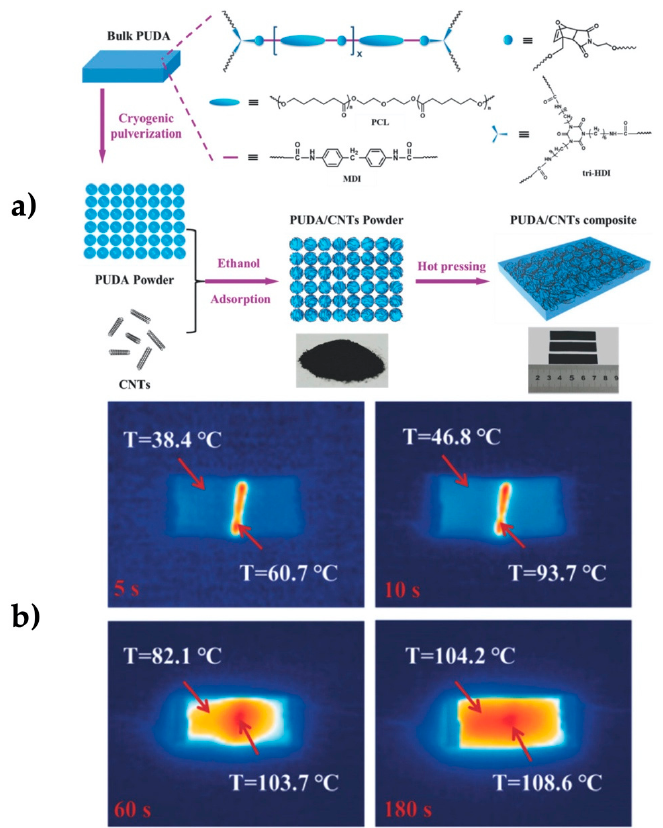
Figure 7. ( a ) Chemical structures of self-healing composite; ( b ) surface temperature of composites connected to electrical current and self-healing [53]. Adapted with permission from Pu, W; Advanced Science; published by Wiley, 2018.